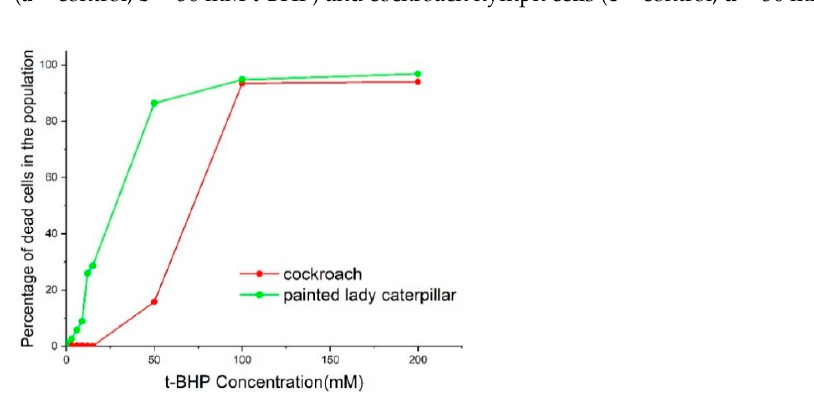
Figure 3. Examples of flow cytometry analysis of cell viability of painted lady caterpillars’ cells ( a = control, b = 50 mM t-BHP) and cockroach nymph cells ( c = control, d = 50 mM t-BHP).